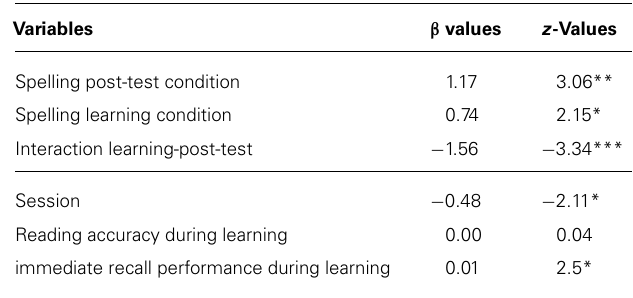
Table 6 | Mixed model analysis on the post-test spelling to dictation results of both experiments. β values for all fixed effects with their z -values and